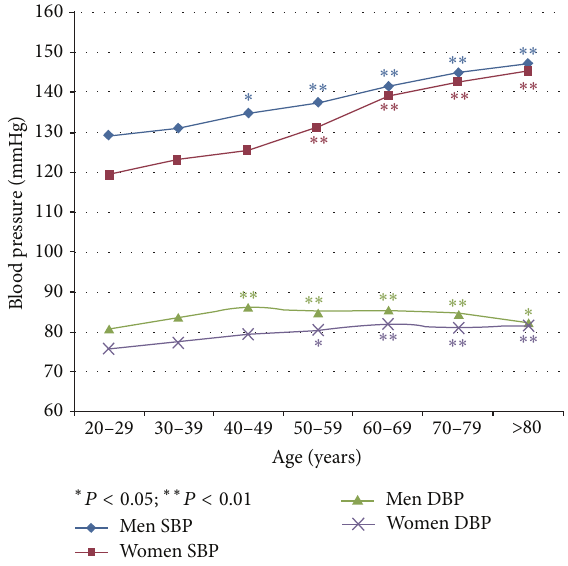
Figure 1: Age affected systolic BP and diastolic BP adjusted for BMI, education levels, and race by gender using multivariate linear regression (group with ages 20–29 used as baseline data which is compared with other age strata